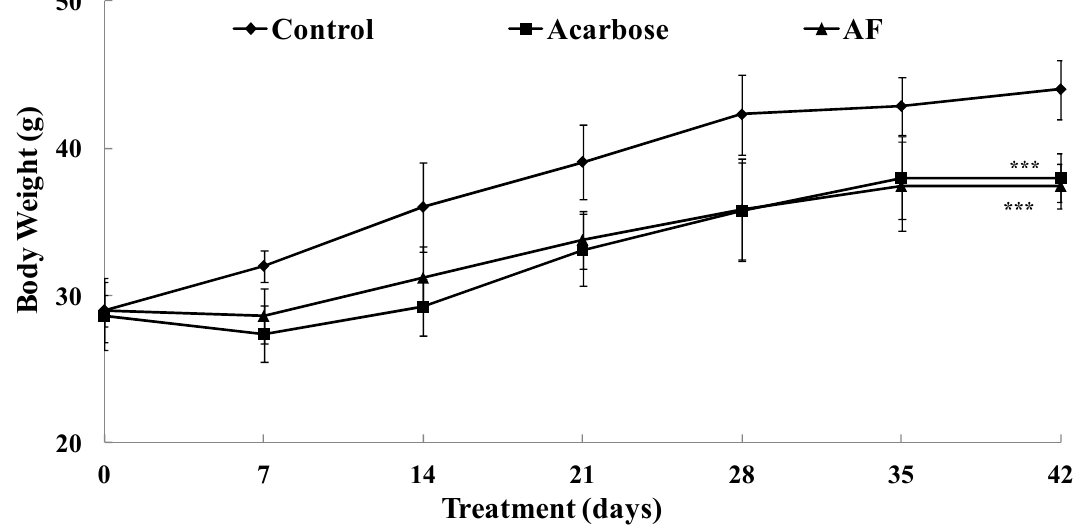
Figure 1. Changes in body weight gains after administration of arginyl-fructose (AF). Male db / db mice were free access to a high carbohydrate-diet with AF (4%), acarbose (0.04%), and vehicle for 6 weeks. Each point represents mean ± standard deviation (SD). ( n = 10). Body weight levels were compared between control and treatment groups at each time point by unpaired Student’s t -test ( *** p <